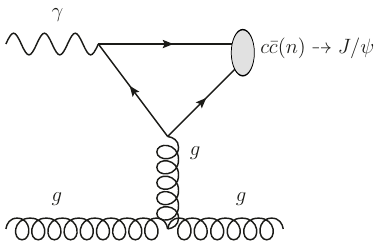
Figure 6 . Feynman diagram of single resolved photoproduction γ + g → c ¯ c ( n = 1 S [ 8 ] g → J/ψ + X